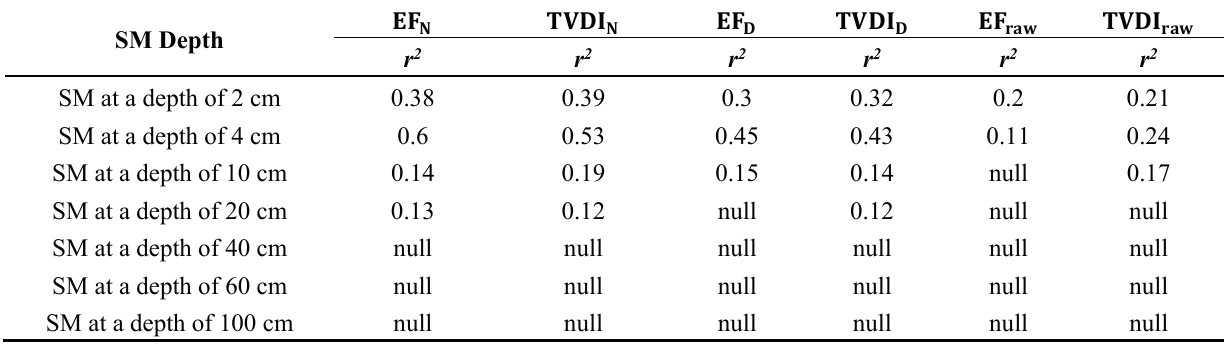
Table 4. The correlation analysis of the dryness indices with different SM depths. SM